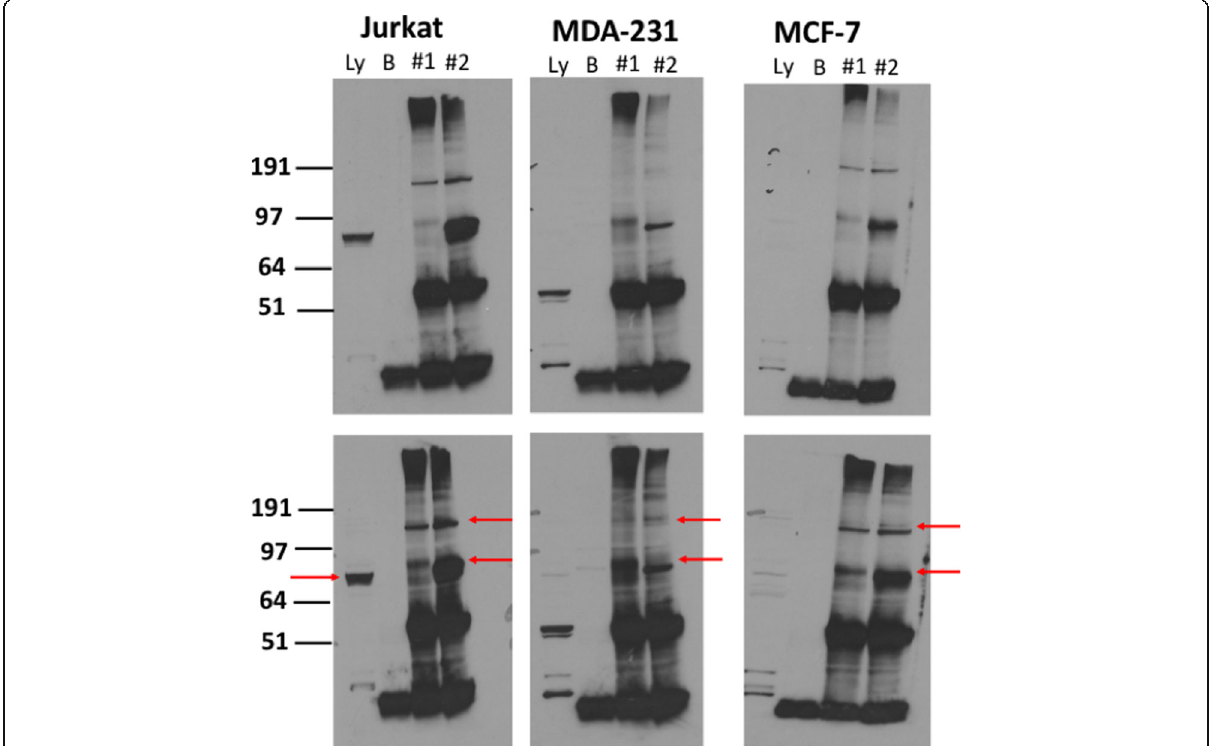
Fig. 4 Western blot analysis for the immunoprecipitated STAG3 protein. Three cancer cell lines, including Jurkat (the positive control), MCF-7, and MDA-MB-231 were used. The STAG3 protein in the lysates (Ly) and those treated with beads and precipitated with either Abcam anti-STAG3 antibody (termed #1) or precipitated with the antibody produced by Sigma (designated #2) as well as beads (B) only was analyzed by Western blot against the antibody manufactured by Sigma to localize protein bands. The upper panel shows blots of the cancer cells exposed to X-ray film for 10 s, while the lower panel refers to the same blot exposed to the film for 30 s. The red arrows represent the postulated STAG3 isoforms